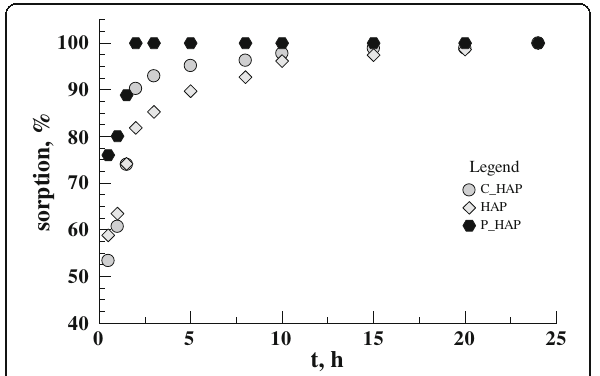
Fig. 13 The kenetics of U(VI) absorption on the P-HAP ( a ) and C- HAP ( b )